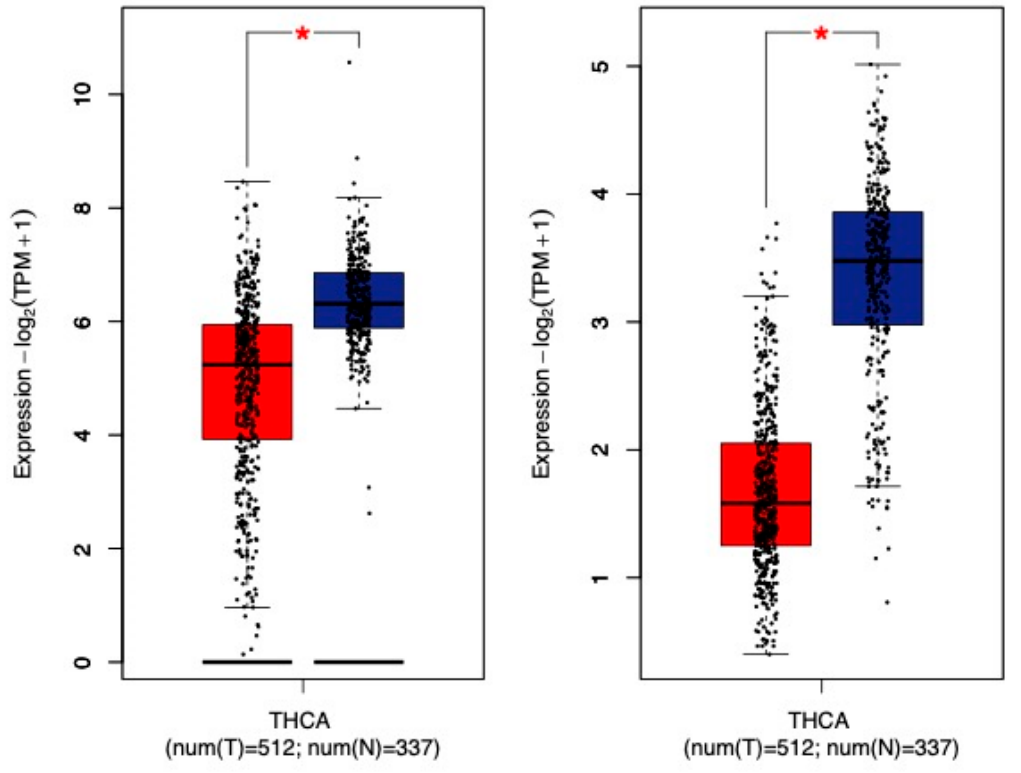
Figure 8. Chemerin and chemerin 1 are decreased in thyroid carcinoma (THCA). The Gene Expression Profiling Interactive Analysis (GEPIA) web server [106] was used for RNA sequencing expression analysis of chemerin and chemerin 1 in thyroid carcinoma (red bars) and normal renal samples (blue bars) from the Cancer Genome Atlas (TCGA) and Genotype-Tissue Expression (GTEx) projects. * p < 0.01. TPM, transcripts per kilobase million.